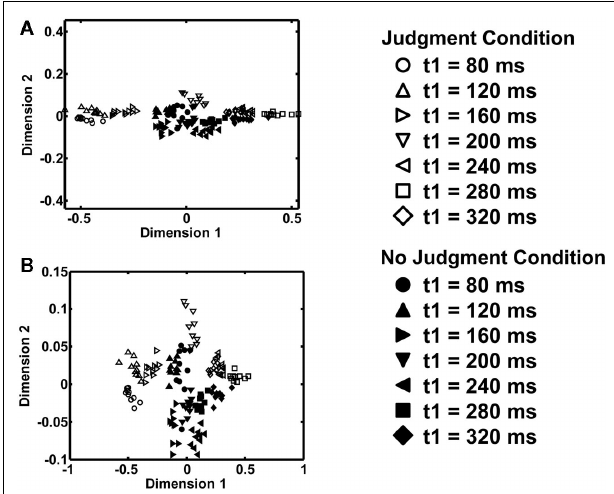
FIGURE 2 | Results of the multidimensional scaling (MDS) analyses. Points representing the activations by the temporal patterns are shown in a two-dimensional layout. Open symbols indicate the results for the judgment condition, and filled symbols the results for the no-judgment condition. Different types of symbols indicate different temporal patterns.The scatter of a symbol shows the variability across different resamplings in bootstrapping ( N = 10). (A) The conventional representation. (B) A vertically elongated